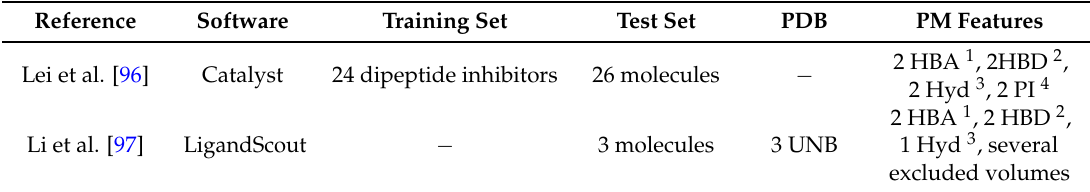
Table 3. Pharmacophore models applied for the discovery of human proteasome inhibitors. Reference Software Training Set Test Set PDB PM Features Lei et al. [96] Catalyst 24 dipeptide inhibitors